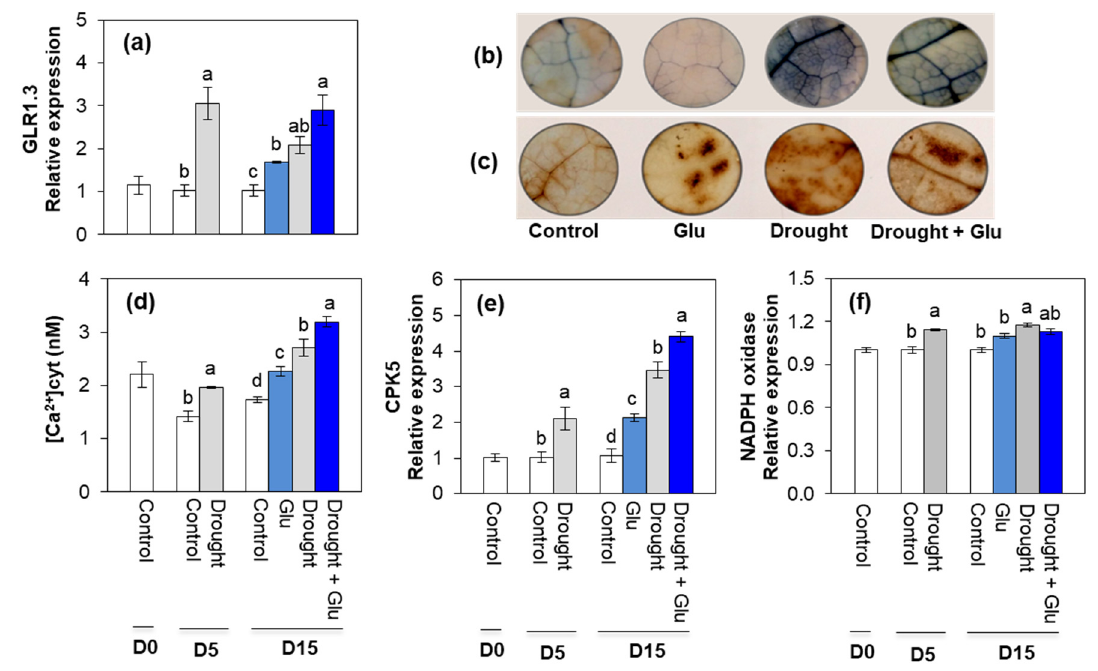
Figure 4. Effects of glutamate (Glu) application on ( a ) gene expression of Glutamate receptor ( GLR1.3 ), ( b ) O 2 •− , and ( c ) H 2 O 2 accumulation visualized by bark blue or brown, ( d ) cytosolic Ca 2 + content, ( e ) calcium-dependent protein kinase 5 ( CPK5 ), and ( f ) NADPH oxidase expression in the leaves of Brassica napus under well-watered or drought-stressed conditions. qRT-PCR was performed in duplicate for each of the three independent biological samples. Values are represented as mean ± SE ( n = 3). Different letters on columns indicate significant difference at p < 0.05 according to Duncan’s multiple range test.